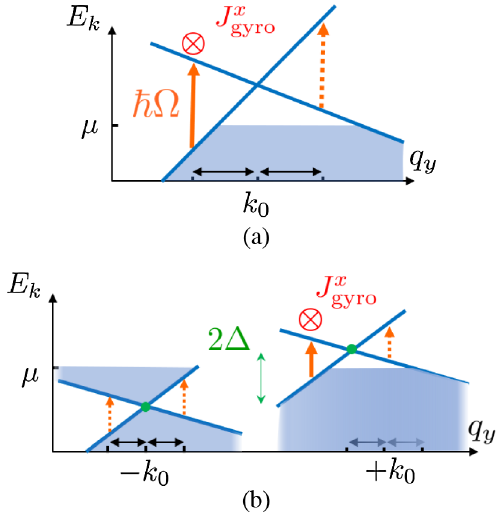
FIG. 4. Mechanism of the enhanced gyration current response in the tilted Dirac system. A coordinate q introduced. (a) Contributions from q out because of the tilting of a single Dirac cone. A dotted arrow represents the transition prohibited by the Pauli blockade. (b) The opposite energy shift (cid:4)j Δ j of the nodes prevents cancellation between two Dirac